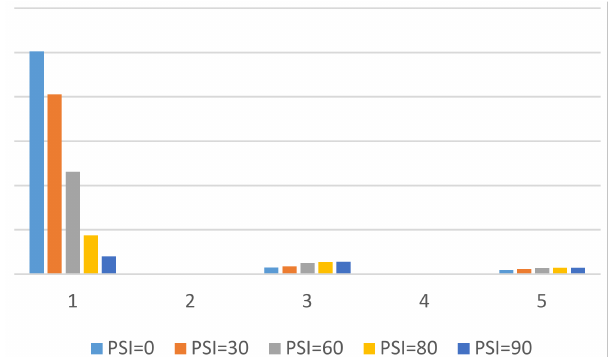
Figure 11. Flux linkage harmonics “1, 3, 5” vs. angle control ( ψ ◦ ).